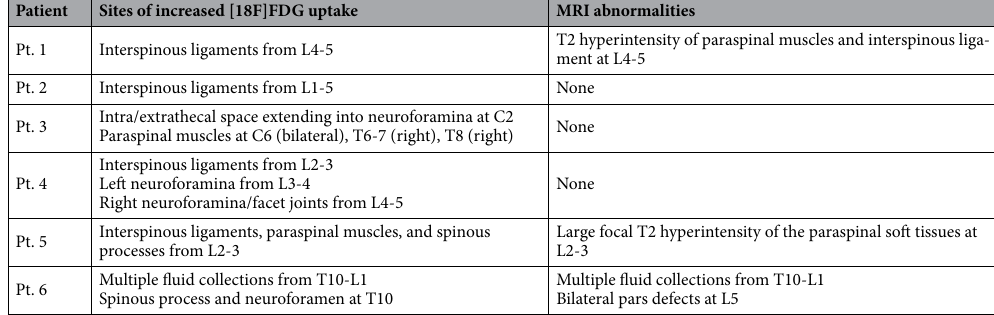
Table 1. Summary of abnormal paraspinal findings from [18F]FDG PET/MRI of 6 patients with suspected CSF leak.